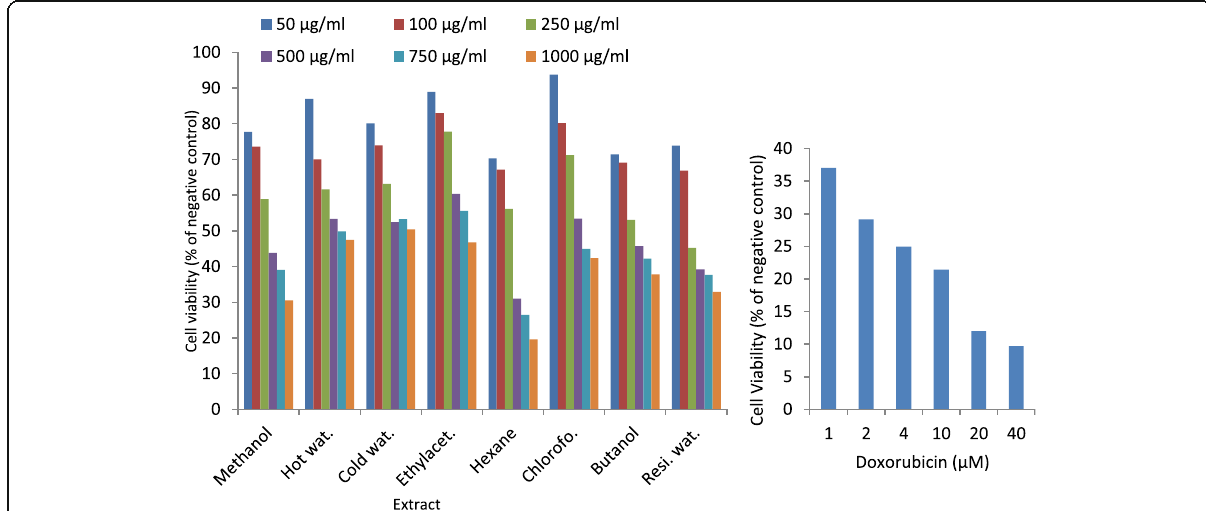
Fig. 1 Antiproliferative activity of Terminalia avicennioides extracts and fractions on HepG2 cell lines as inhibition of cell viability expressed as percentage (of negative control). Data represent the mean ± SD (standard deviation) of two independent experiments. Data for doxorubicin as positive control are shown for